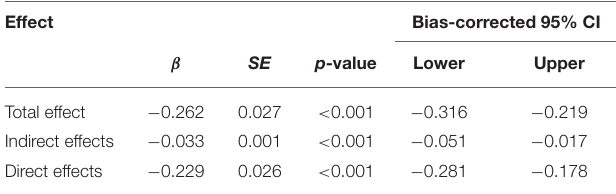
TABLE 4 | The mediating effect of sleep quality on the relationship between SC and depressive symptoms *